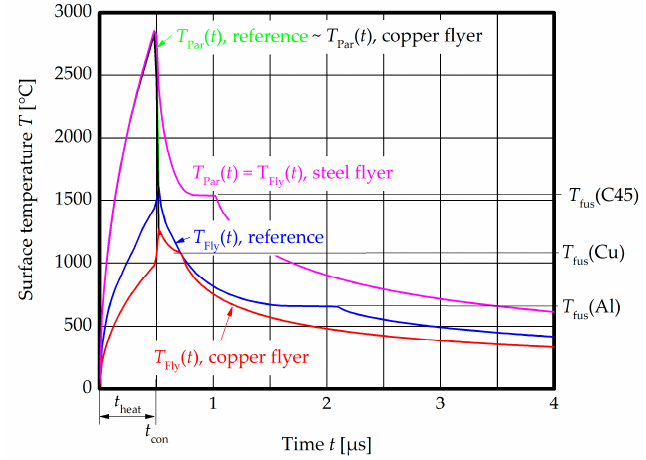
Figure 21. Comparison of T Fly ( t ) and T Par ( t ) for the reference setup and the setups with copper and C45 as flyer materials.